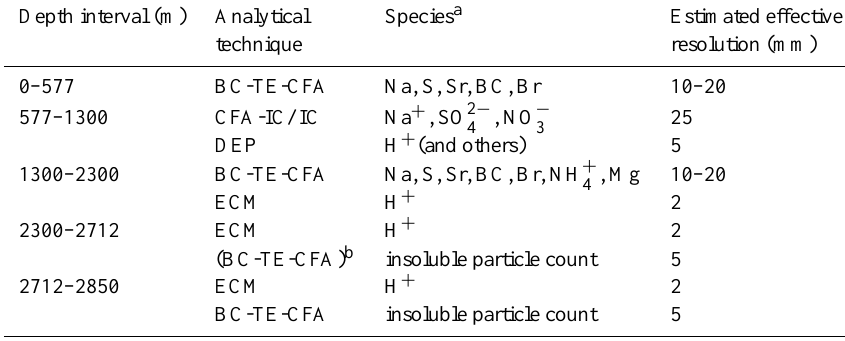
Table 1. Data used in the construction of the WD2014 ice core